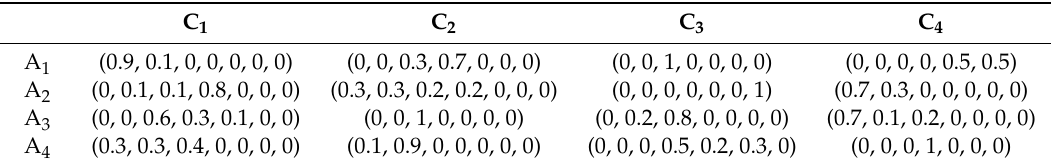
Table 4. Possibility distribution hesitant fuzzy linguistic decision matrix by expert E 1 .